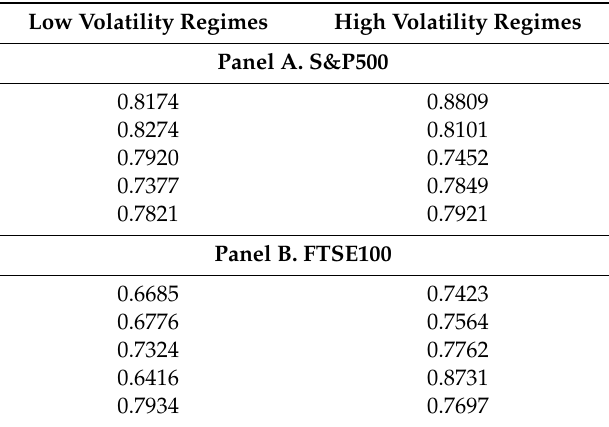
Table 4. Estimation results in low and high volatility